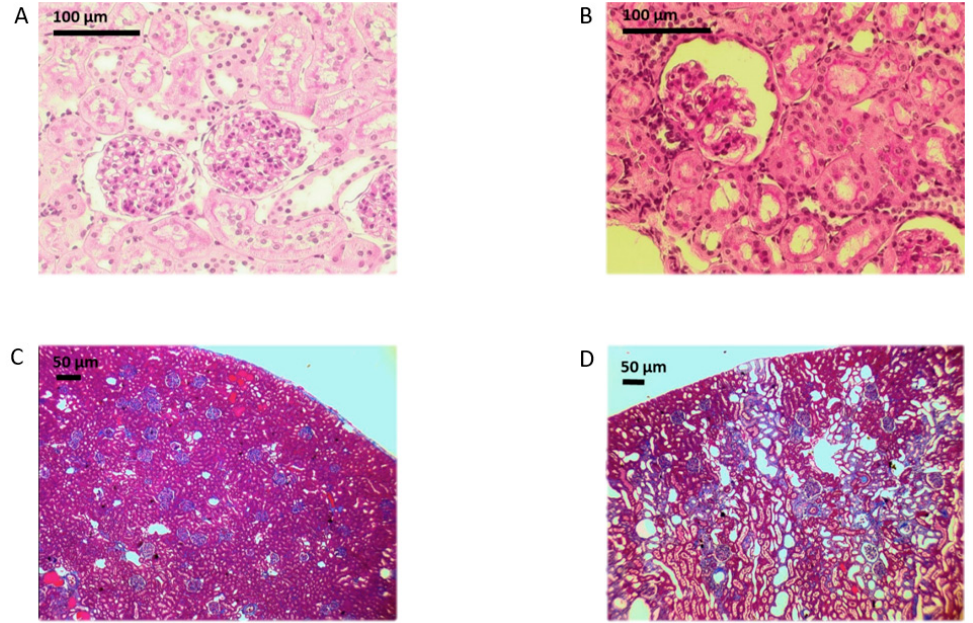
Figure 2. Rat models of kidney disease. Representative photomicrograph (10×) of periodic acid Schiff- Schi ff -stained kidneys from a control ( A ) and a purumoycin aminonucleoside (PAN)-administered Sprague-Dawley (SD) rat. ( B ) Scarring of the glomerulus is clearly evident in the latter.